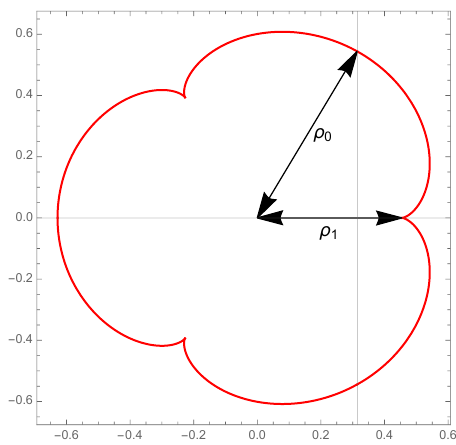
Figure 12 . Solution with three inward spikes and one winding for ρ 0 = π/ 5 and ρ 1 ’ 0 . 46 .